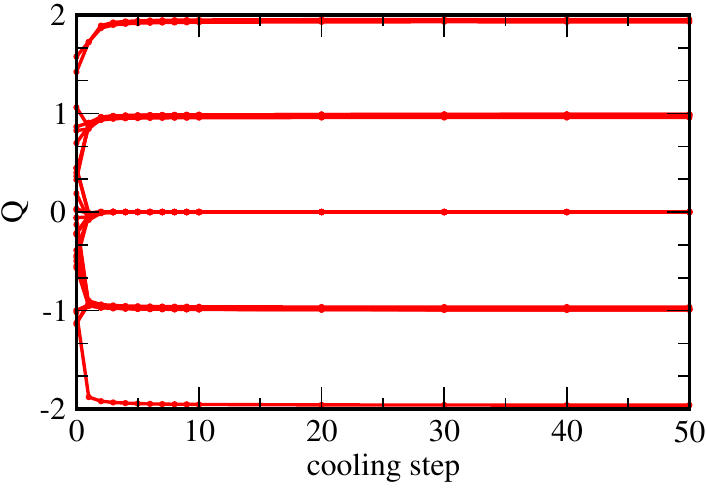
Figure 2 . Cooling step dependence of the topological charge on the TBC lattice.